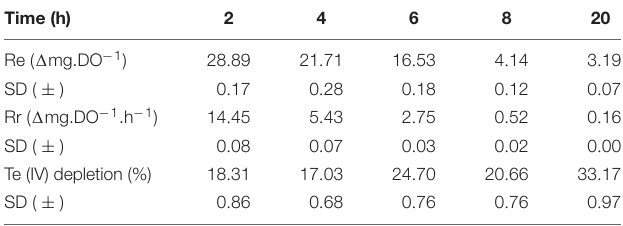
TABLE 1 | Reduction efficiencies, reduction rates, and percentage of Te (IV) depletion all through the growth of Paenibacillus pabuli ALJ109b in the presence of 5 × 10 − 4 M of Te